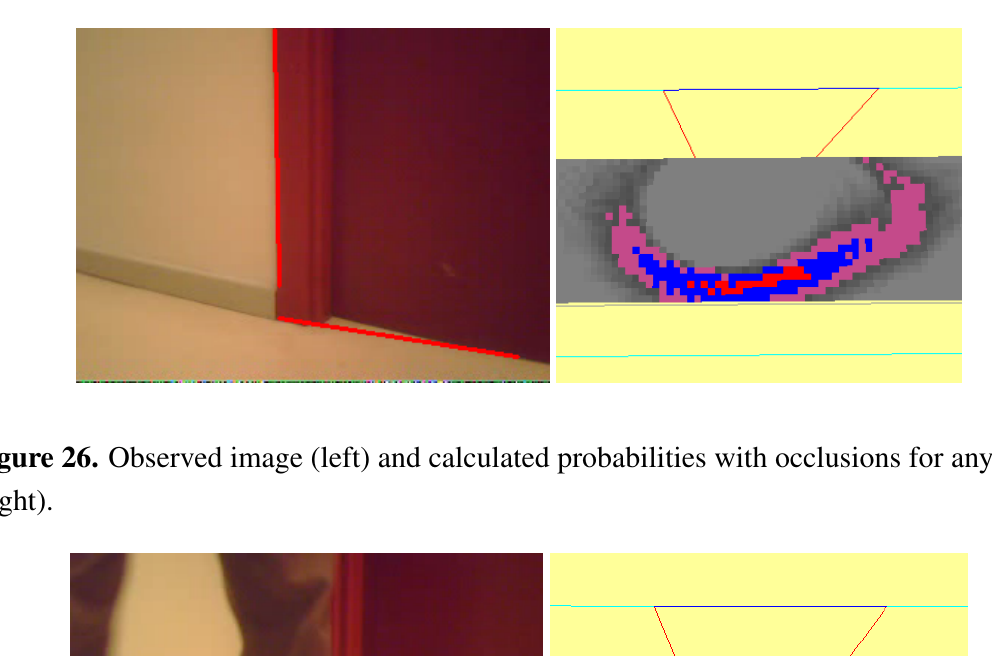
Figure 25. Observed image (left) and calculated probabilities without occlusions or false positives for any theta (right).